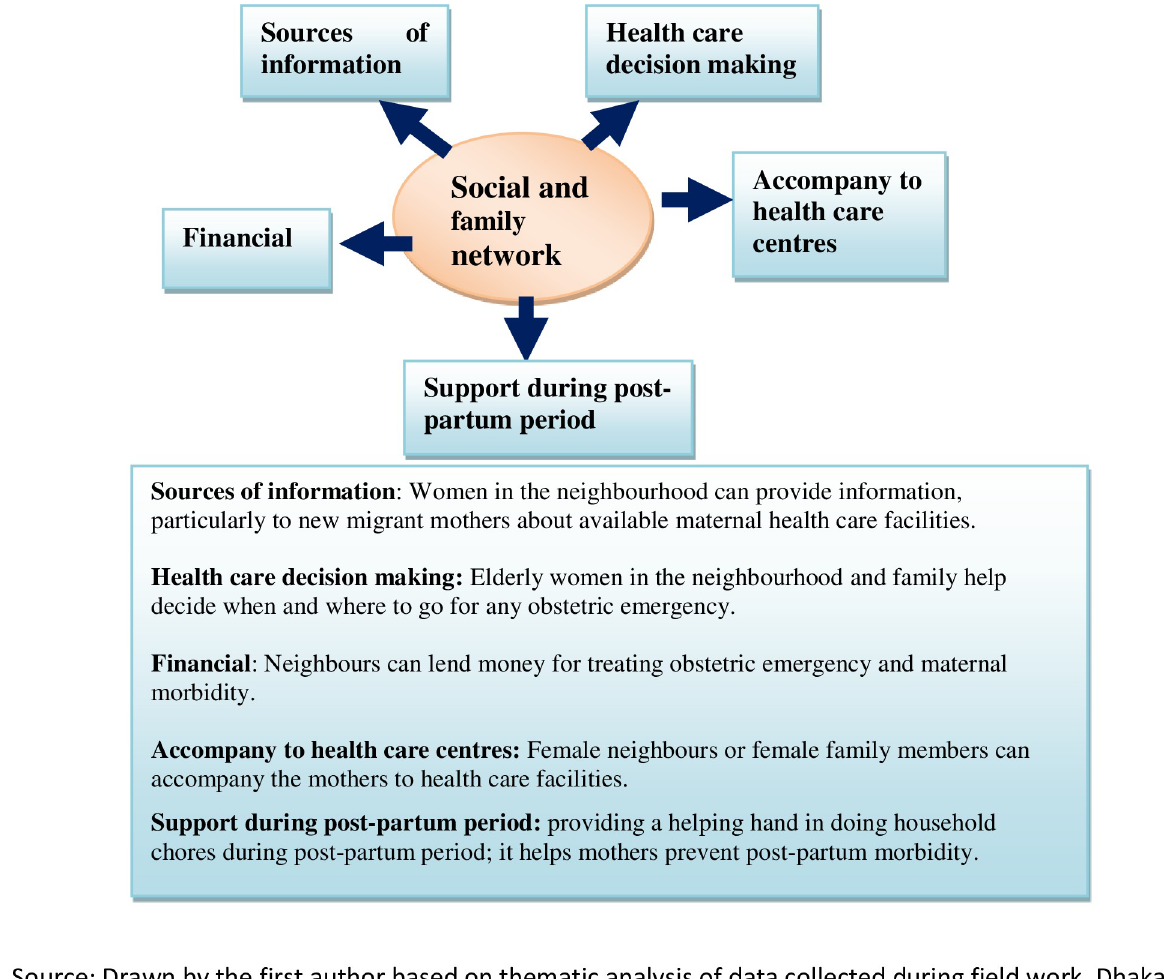
Fig 1. Support that social and neighbourhood networks